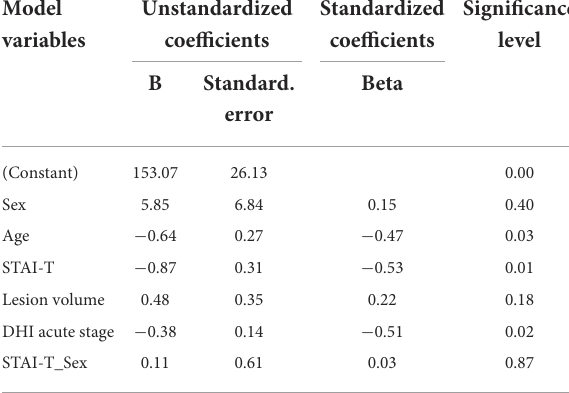
TABLE 2 Multiple linear regression model with DHI at follow-up as dependent variable and outcome parameter. Model Unstandardized Standardized Significance